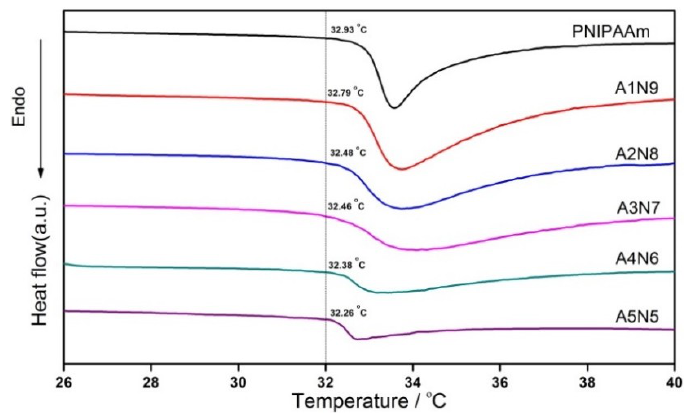
Figure 8. DSC curves for composite hydrogels prepared by different ASF content.